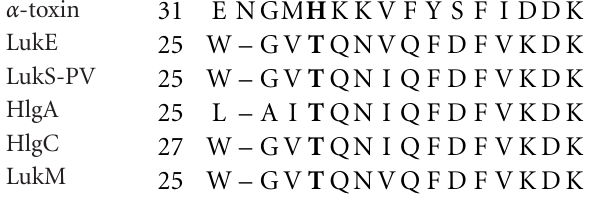
Figure 2: Partial alignment α -toxin sequence and class S compo- nent sequence of the